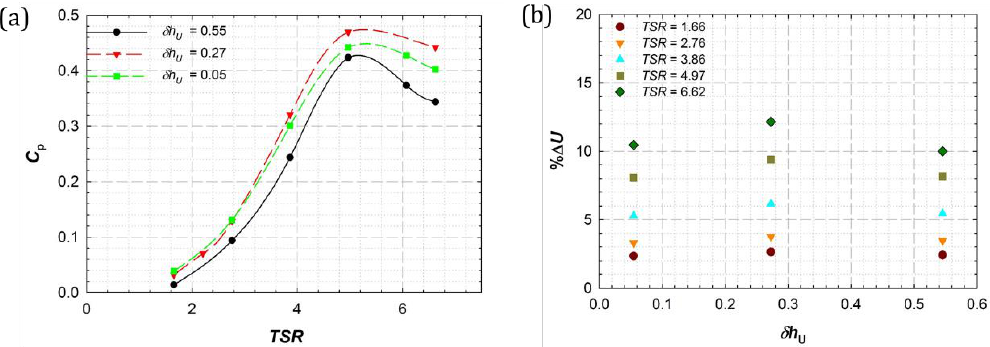
Figure 2. E ff ect of tip clearance ratio on ( a ) power coe ffi cient and ( b ) percent change in e ff ective channel Figure 2. Effect of tip clearance ratio on ( a ) power coefficient and ( b ) percent change in effective velocity as a function of TSR for U ∞ = 0.8 m / channel velocity as a function of TSR for U ∞ = 0.8 m/s.